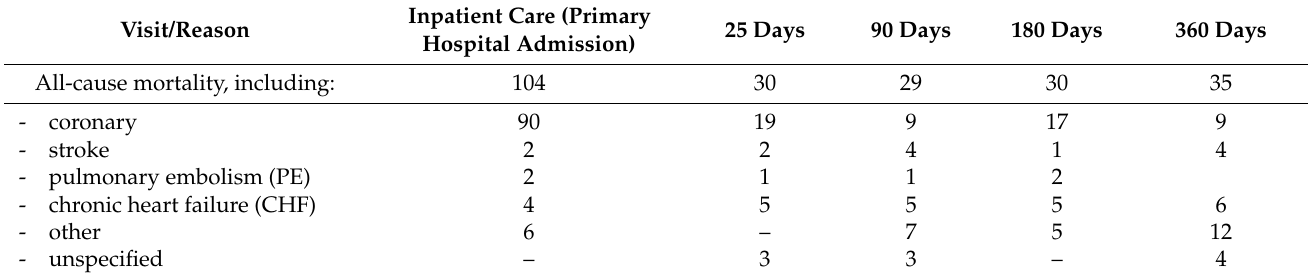
Table 1. Distribution of causes of death by the time of follow-up.